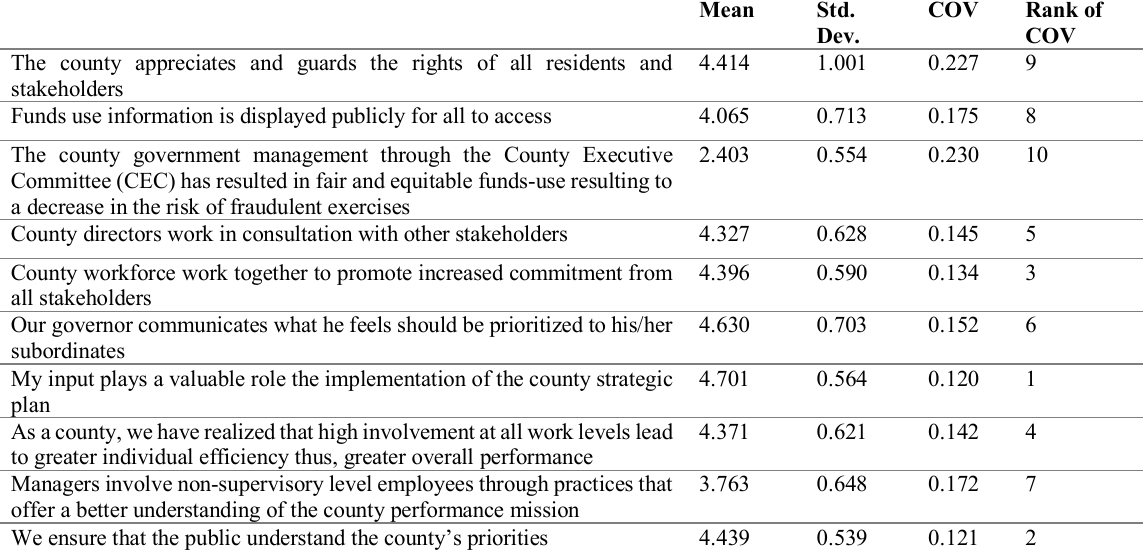
Table 3: Statements on consensus